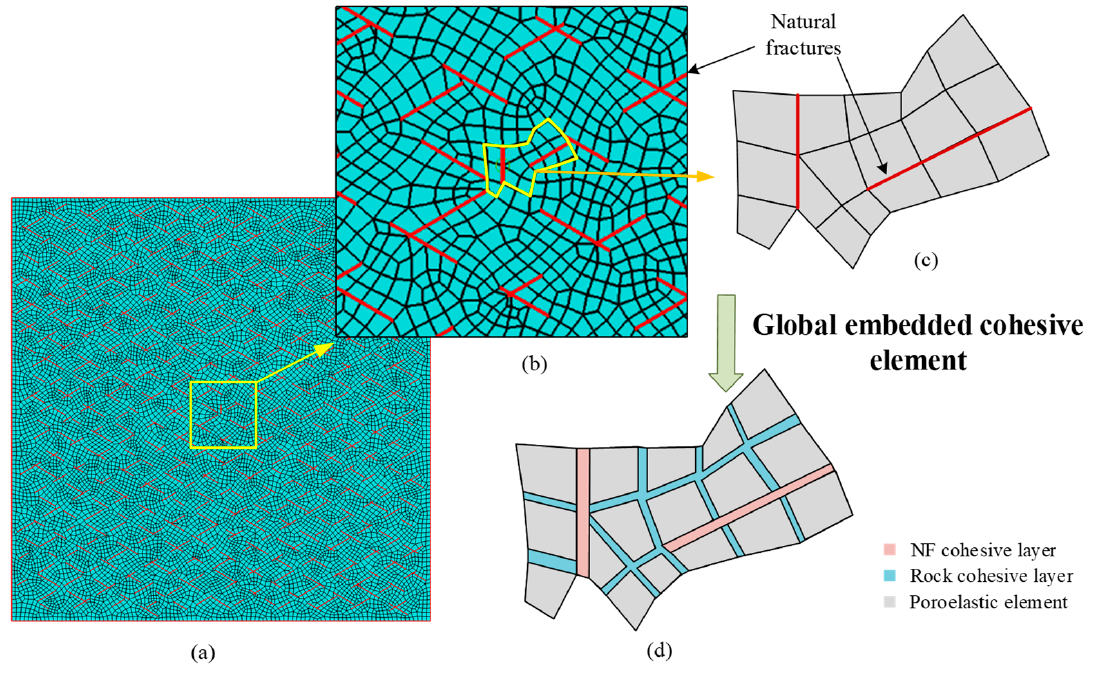
Figure 7. Schematic diagram of the natural fractures network model established using global cohesive elements. ( a ) Mesh generation of the natural fractures network model. ( b ) The mesh is locally enlarged to show the location of the natural fracture more clearly. ( c ) Mesh before embedding cohesive element. ( d ) Mesh after global embedding cohesive elements. Table 1. Relevant parameters for the model.